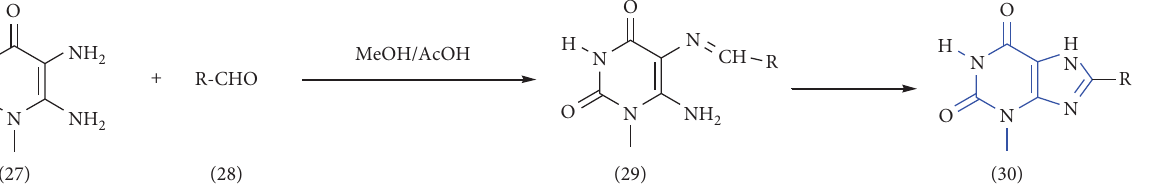
Scheme 3: Synthesis of 8-cyclopentyloxyphenyl xanthine derivatives.